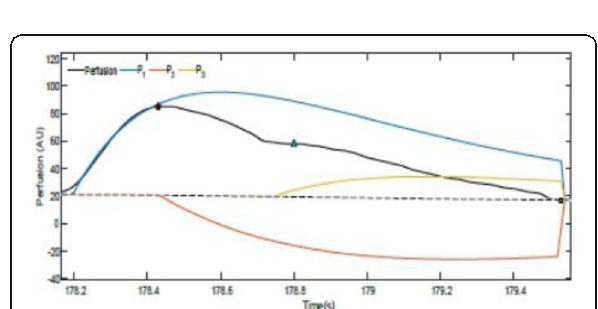
Fig. 2 (abstract A150). Sample model curve, generated by a proper combination of three exponential